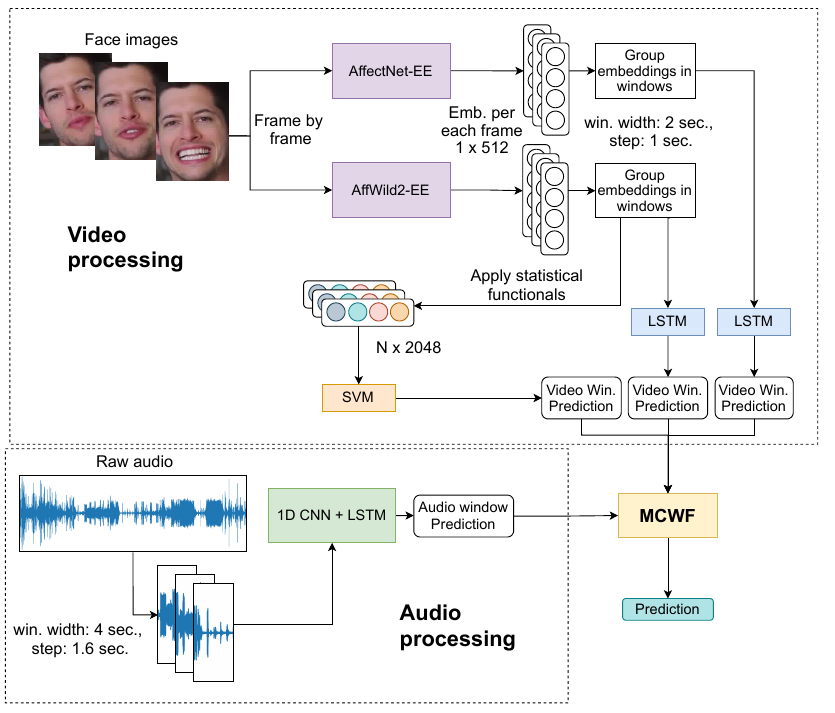
Figure 1. The proposed pipeline for the multimodal emotion recognition system: Emb.—Embeddings, Win.—Window, MCWF—Model- and Class-based Weighted